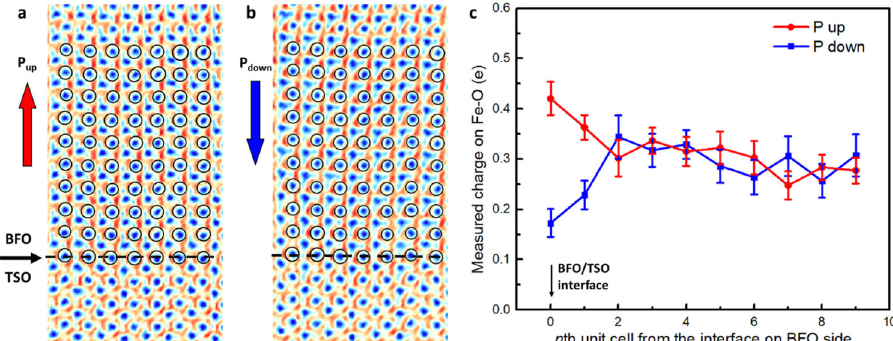
Fig. 3 Charge quanti fi cation based on charge density maps. a , b Charge density maps of Fig. 2 c, f, respectively, with the Fe/O columns de fi ned by black circles. c Averaged measured charge on Fe/O columns of each unit cell row as a function of number of unit cells from the BFO/TSO interface. Red and blue arrows and dots represent upward and downward polarization states, respectively. Error bars denote the standard deviation of each row.